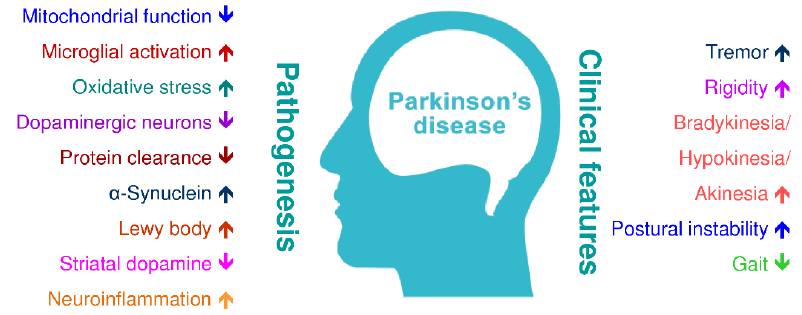
Figure 2. Pathogenesis and clinical features of Parkinson’s disease. Diagram illustrates the neurodegenerative changes leading to dopaminergic neuronal death, pathogenesis, and the clinical features of Parkinson’s